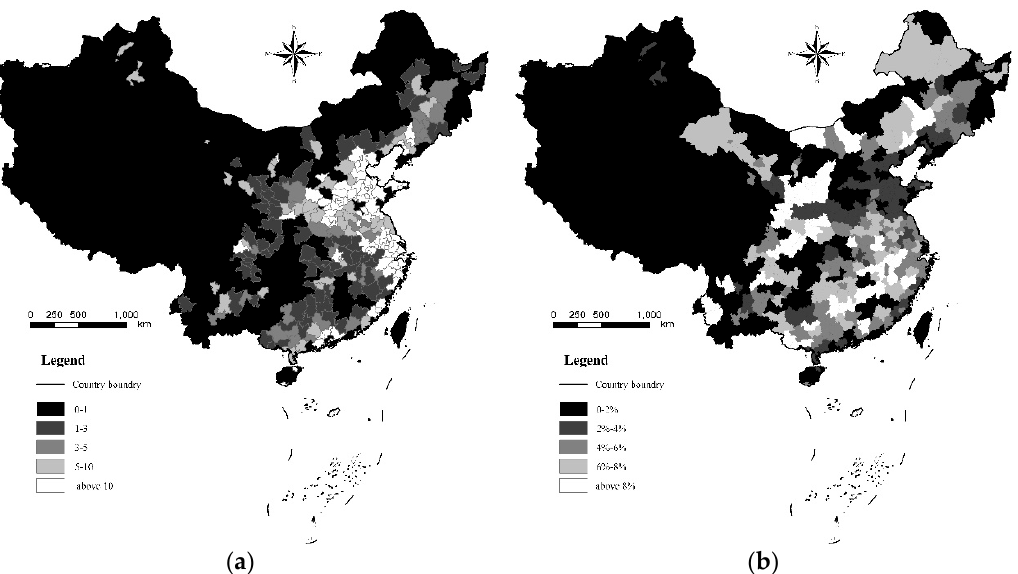
Figure 2. Nighttime lighting in Chinese cities (2000–2013). ( a ) Average nighttime light; ( b ) Annual change in nighttime light. change in nighttime